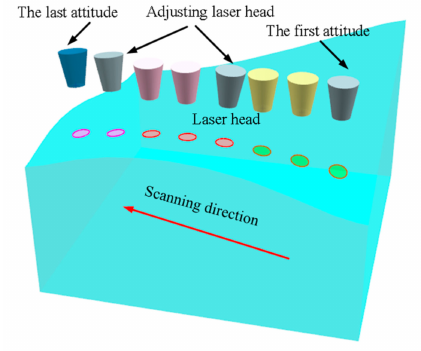
Figure 4. Diagram of the adjusting laser